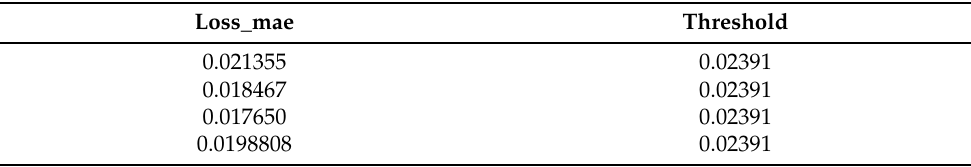
Table 4. Result of selecting threshold value according to loss